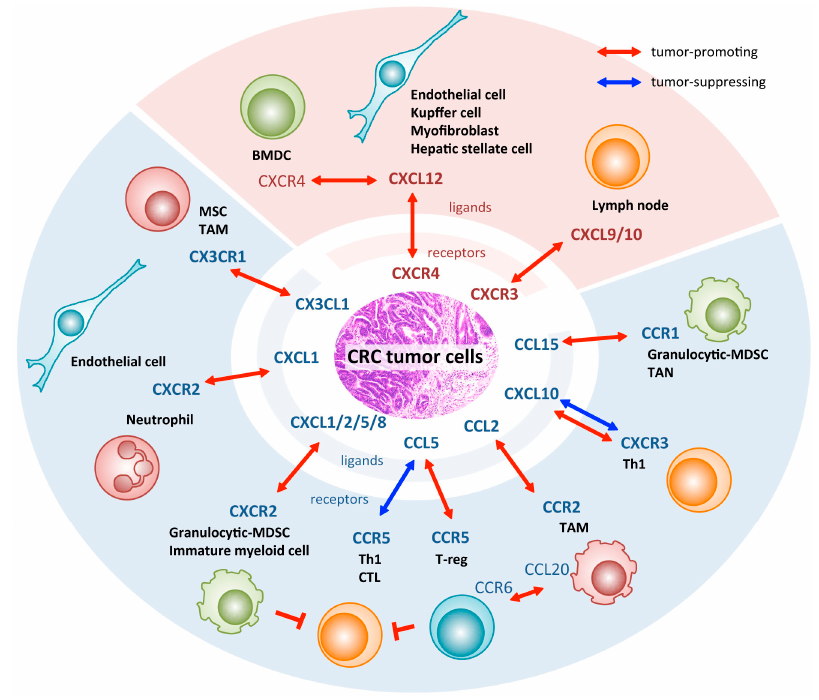
Figure 1. Chemokine signaling that mediates interactions between CRC cells and myeloid cells in the tumor microenvironment.